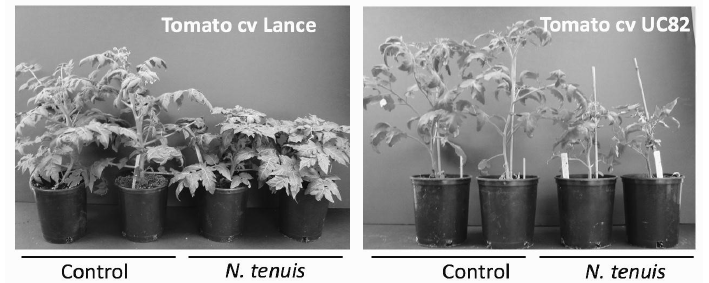
Figure 8. Nesidiocoris tenuis visual damage in the cv. Lance and cv. UCB2 tomatoes. Plant growth was visually inspected one month after infestation by comparing with non-inoculated plants. In both varieties, N. tenuis stunted plants and decreased